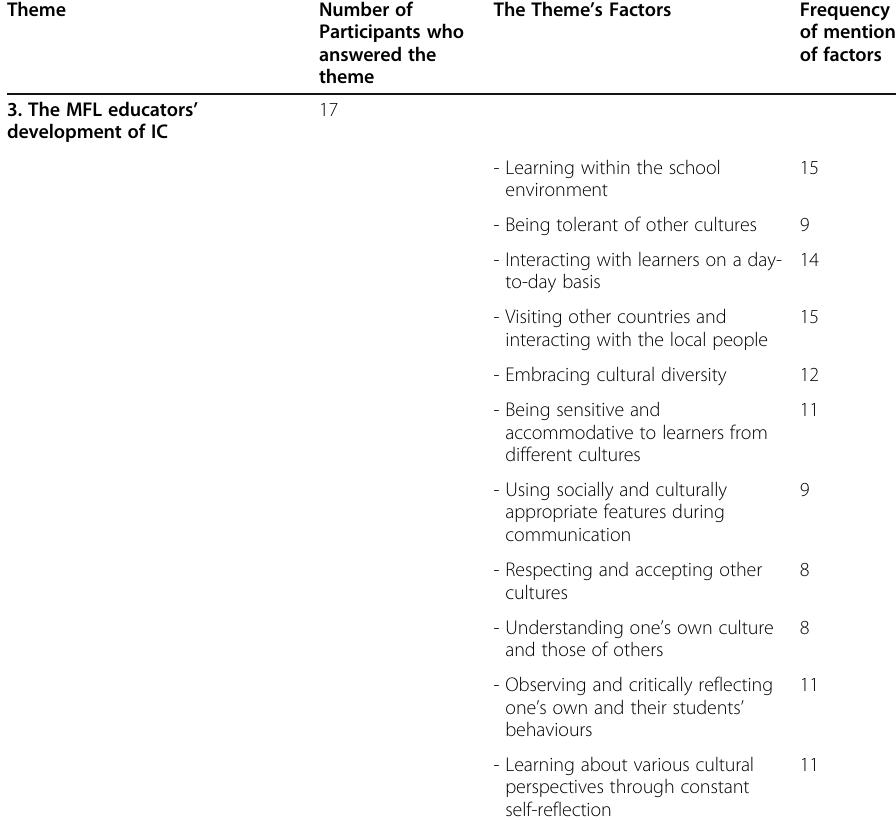
Table 1 The Study Main Themes (Continued)